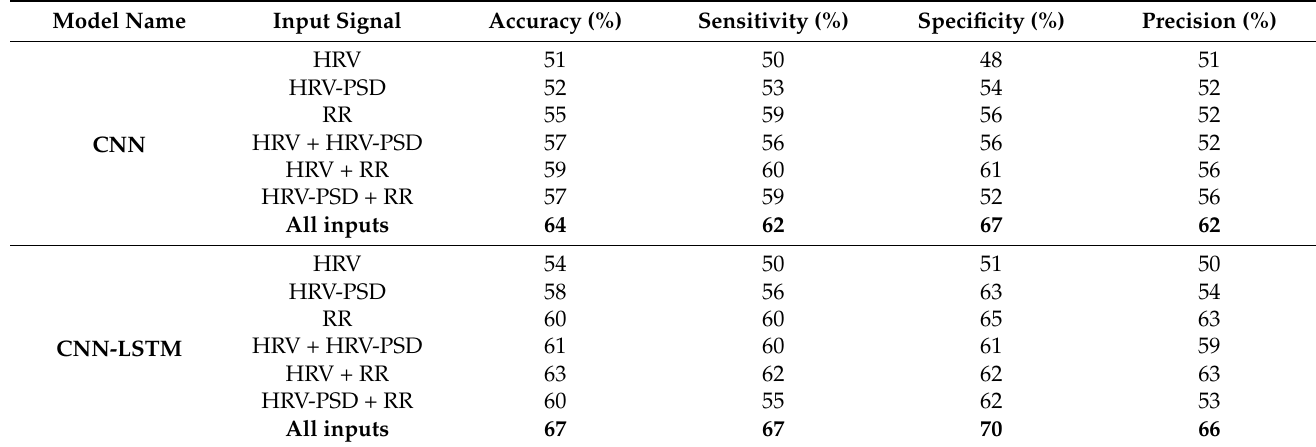
Table 3. Performance of the CNN and CNN-LSTM models for the five-level drowsiness classifications for different combinations of input